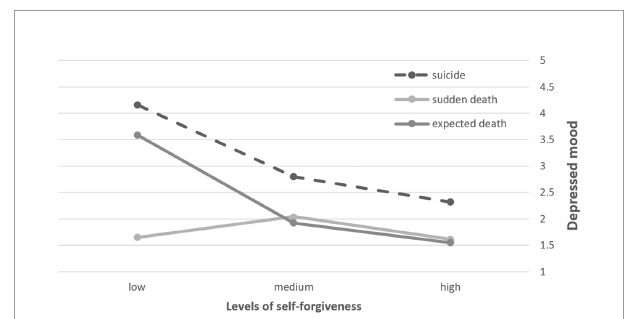
FIGURE 1 | Depressed mood as a function of self-forgiveness (SF) and type of loss ( N = 309).